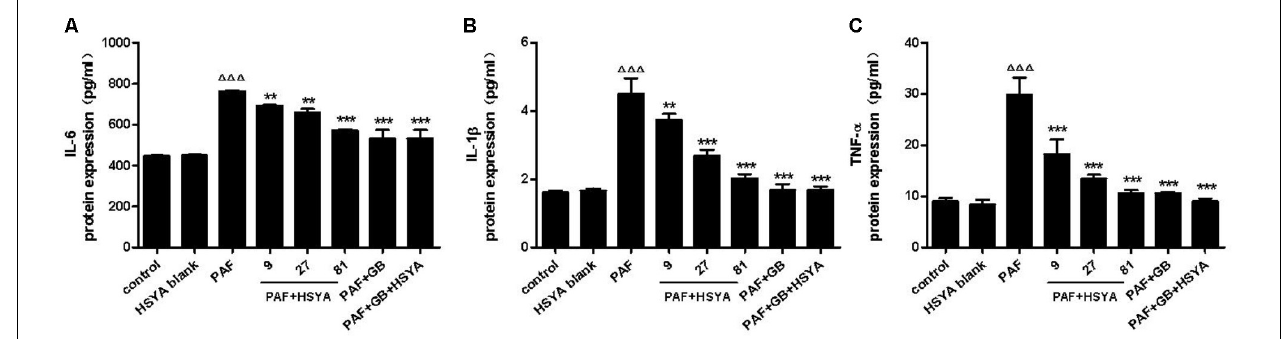
FIGURE 4 | Effects of HSYA on IL-6 (A) , IL-1 β (B) , and TNF- α (C) protein expression levels in PAF-stimulated HSAECs measured by ELISA. Data presented as mean ± SD, n = 3 per group. ANOVA, p < 0.0001 (A) , p < 0.0001 (B) , p < 0.0001 (C) . post hoc (cid:49)(cid:49)(cid:49) p < 0.001 versus control group, ∗∗ p < 0.01, ∗∗∗ p < 0.001 versus PAF group.